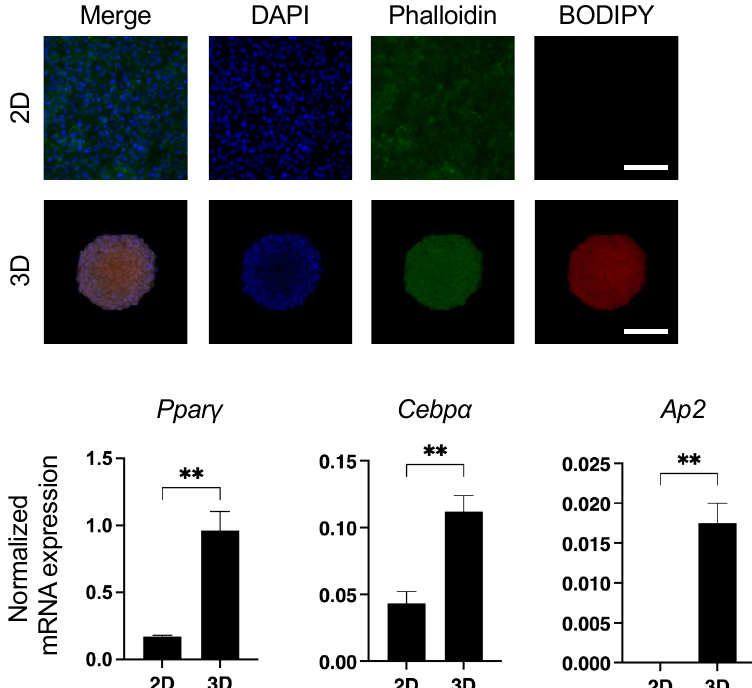
Figure 1. Spontaneous adipogenic differentiation in 3D 3T3-L1 spheroids. Representative images of lipid staining of 2D- and 3D-cultured 3T3-L1 cells with BODIPY, DAPI, and phalloidin are shown in upper panels (scale bar; 100 µ m). In the lower panels, 2D- and 3D-cultured 3T3-L1 cells at Day 7 were subjected to qPCR analysis of Ppa γ , Cebpa , Ap2 ( Fabp4 ), AdipoQ , and leptin , and the resulting plots of Ppar γ , Cebpa, and Ap2 are shown (AdipoQ and leptin expressions were not detected in both 2D and 3D). All experiments were performed in duplicate using fresh preparations consisting of 5 or 16 of 3D spheroids each for lipid staining or qPCR analysis, respectively, or 2D-cultured cells ( n = 4 wells from 6 well culture dish) for both analyses. Data are presented as arithmetic mean ± standard error of the mean (SEM). ** p < 0.01 (unpaired t